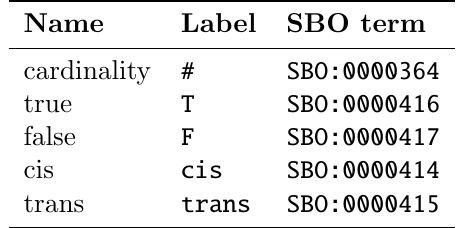
Table 2.4: Miscellaneous controlled terms (Section 2.4.4). For the cardinality, # stands for a number, for example, “ 5